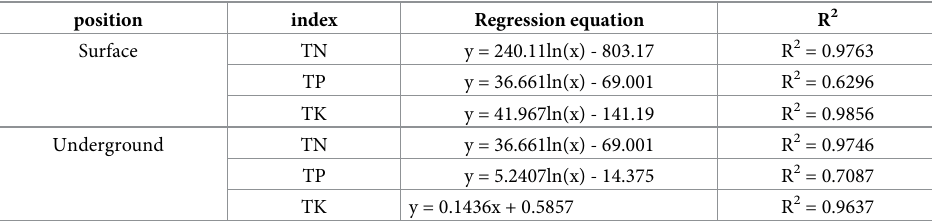
Table 4. Fitting regression equation of rainfall intensity and runoff nutrient loss.